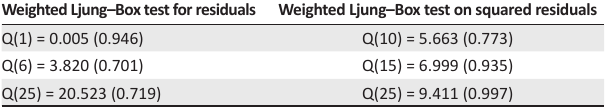
TABLE 2b: South Africa – Specification for the rate of change of exchange rate: A [MA(1)] model. Weighted Ljung–Box test for residuals Weighted Ljung–Box test on squared residuals